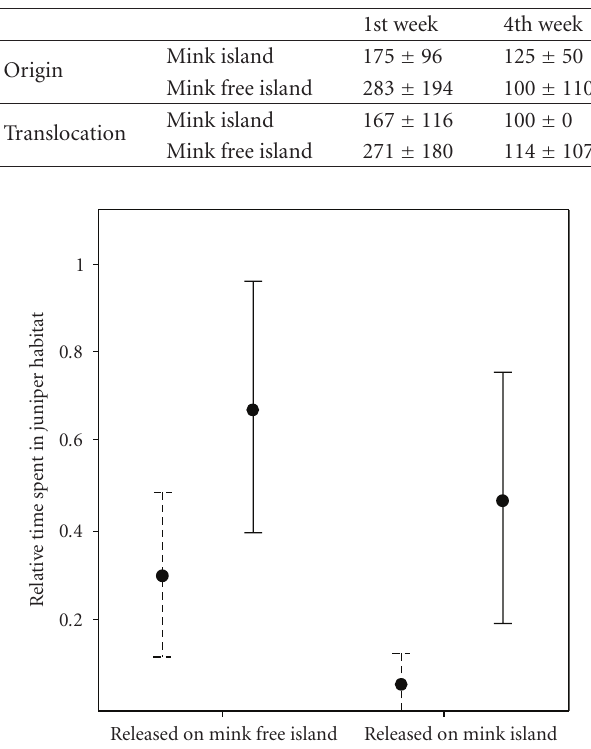
Figure 2: The relative time that “experienced” (solid line) and “inexperienced” (dashed line) voles released on mink-free and mink islands spent in juniper in relation to all localisations. Averages and error bars show standard